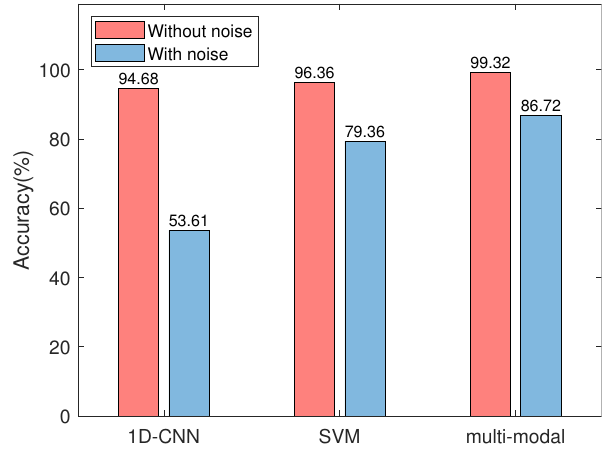
Figure 8. The influence Comparison of noise on accuracy. Effect of SVM Parameters. After projecting the sensor features into the common space, we use SVM as a classifier. Figure 9a shows the influence of four classical kernel parameters and faster speed. In Figure 9b, the influence of penalty factor on SVM is tested.